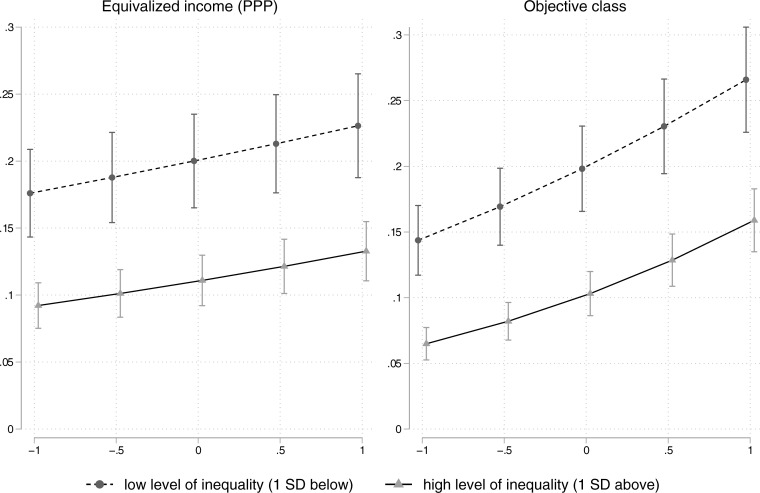
Predicted probabilities of donating derived from the models presented in Table 9.